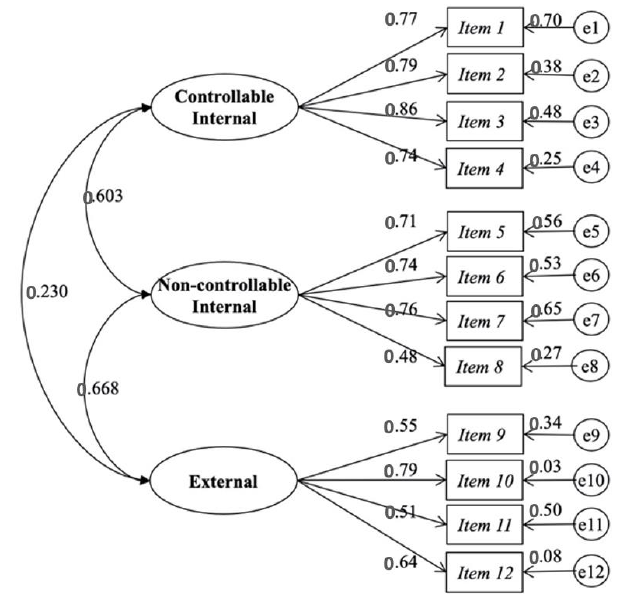
Figure 2. Model of three related factors of the Scale of Attributions of the Academic Failure.